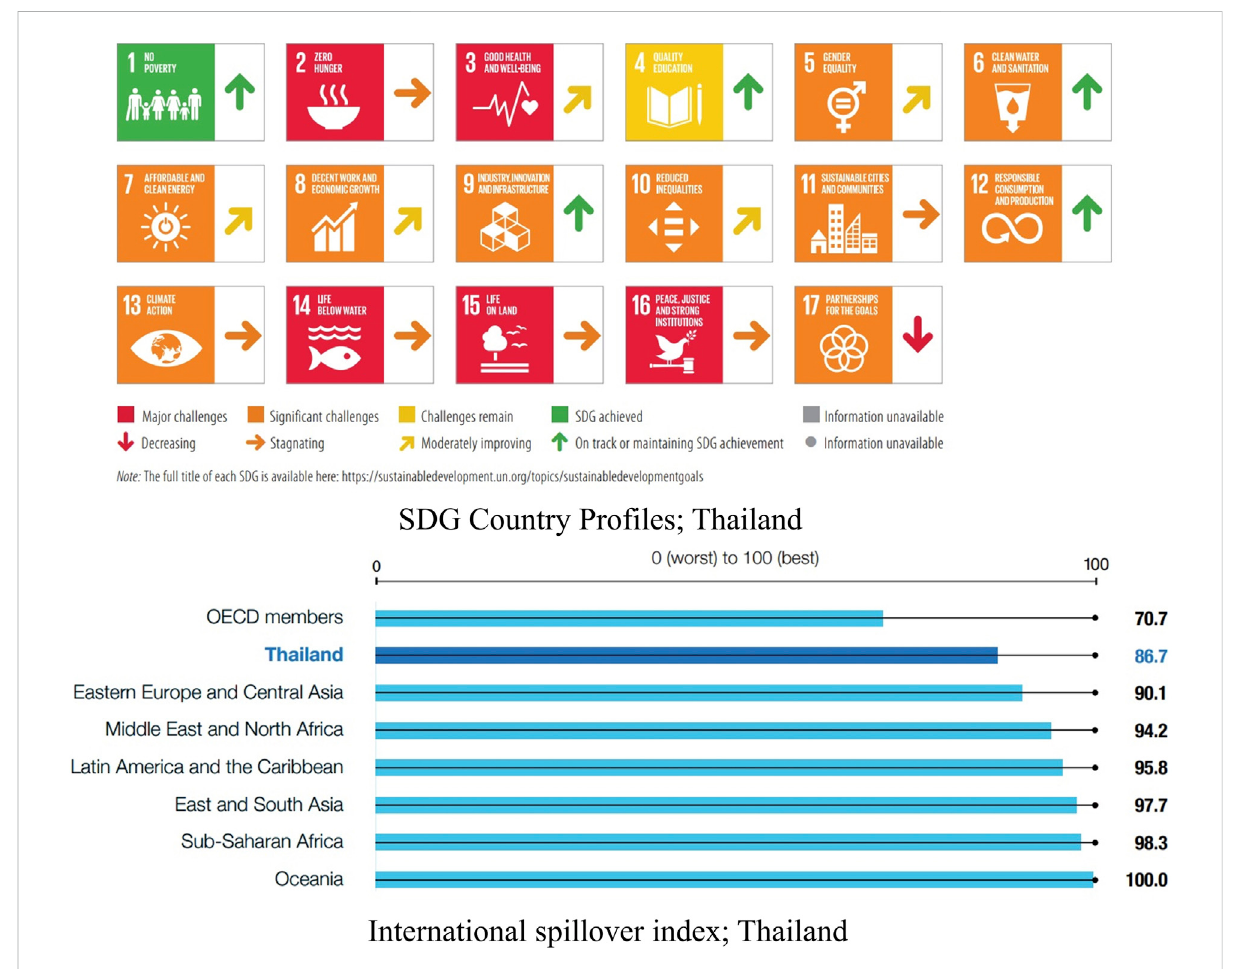
FIGURE 1 SDG Country Pro fi les and International spillover index; Thailand, sourced (Sachs et al.,